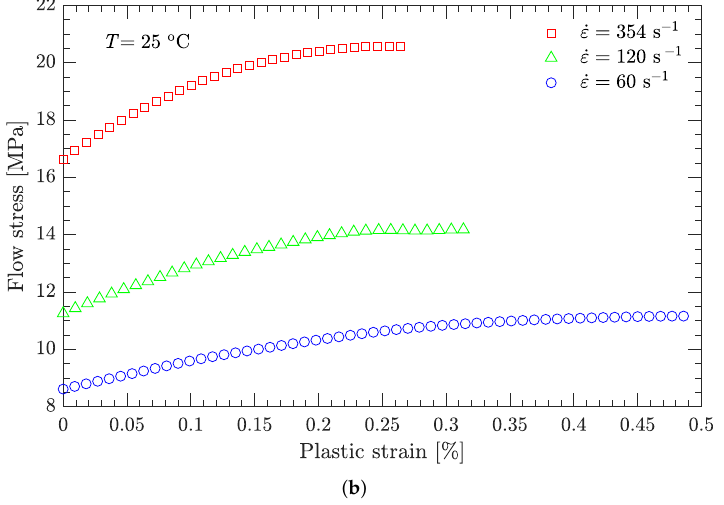
Figure 6. Measured flow stress vs. plastic strain at a temperature of 25 ◦ C. ( a ) Static compression;